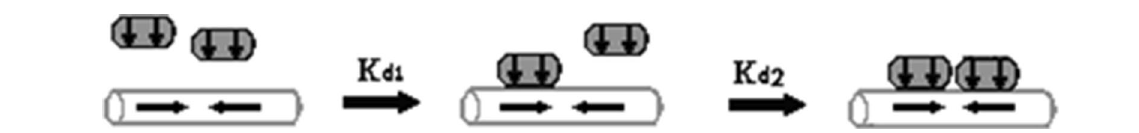
Fig. 3 Graphical representation of two-site